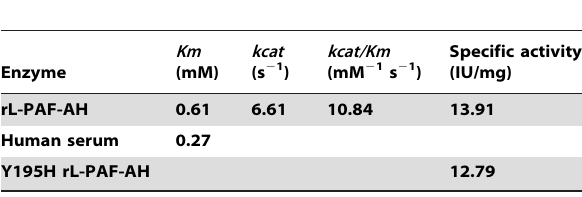
Table 1. Kinetic parameters of rL-PAF-AH, human serum and the specific activity of Y195H